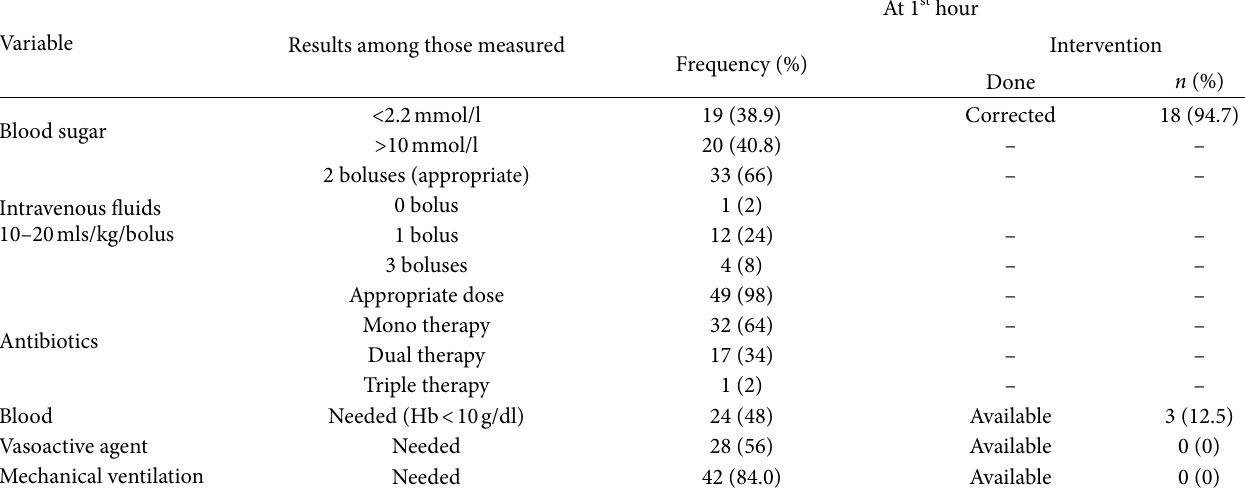
Variable Results among those